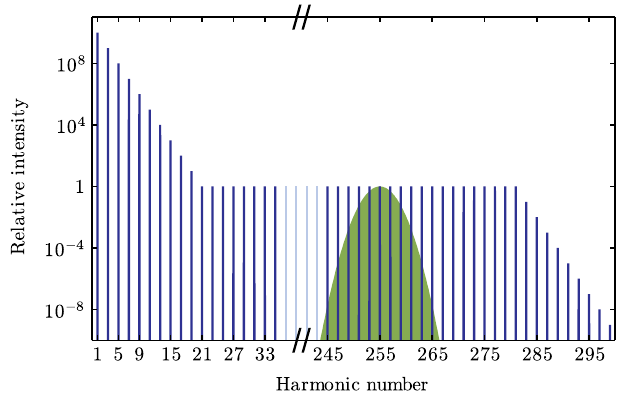
FIG. 3. Relative intensities of harmonic orders 1–35 and 245–299 of an input HHG seed spectrum. The shaded green Gaussian around the 255th harmonic (also plotted on a logarith- mic scale) represents the FEL gain curve for (cid:4) ¼ 5 (cid:6) 10 (cid:5) 3 .